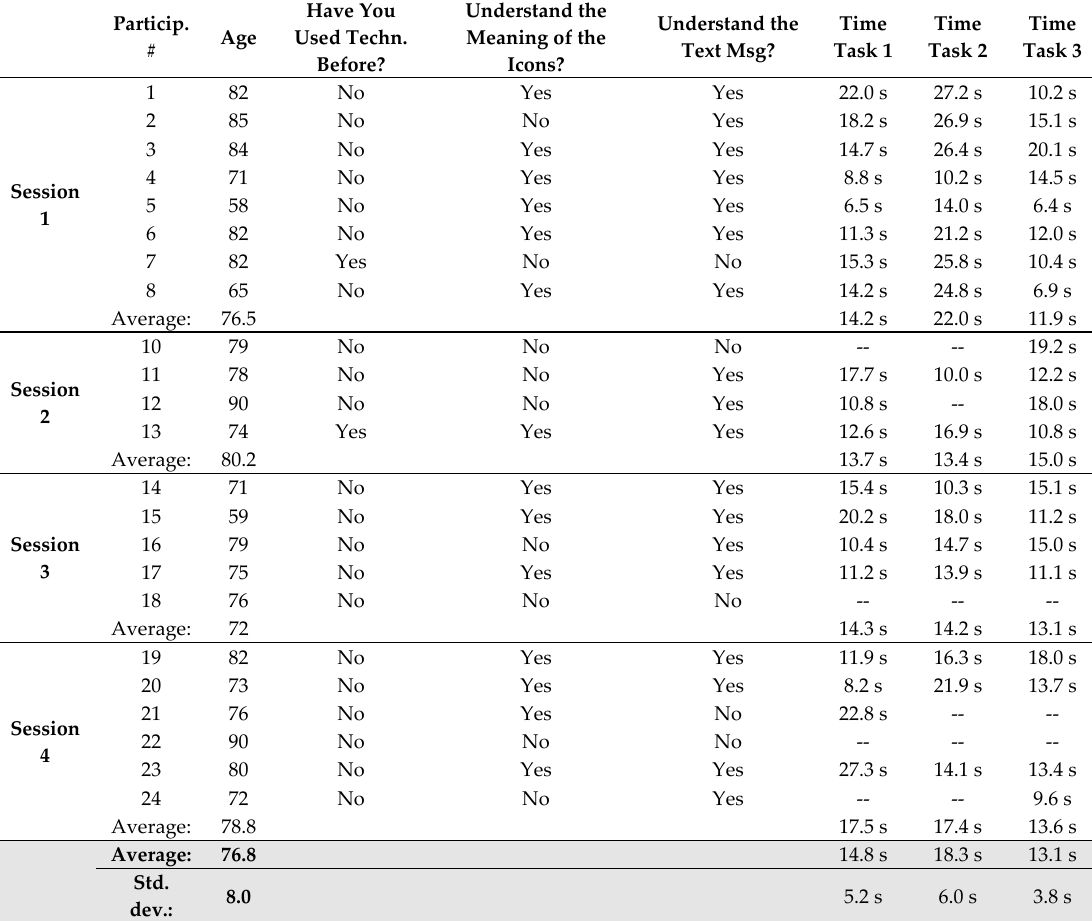
Table 3. Summary of the obtained